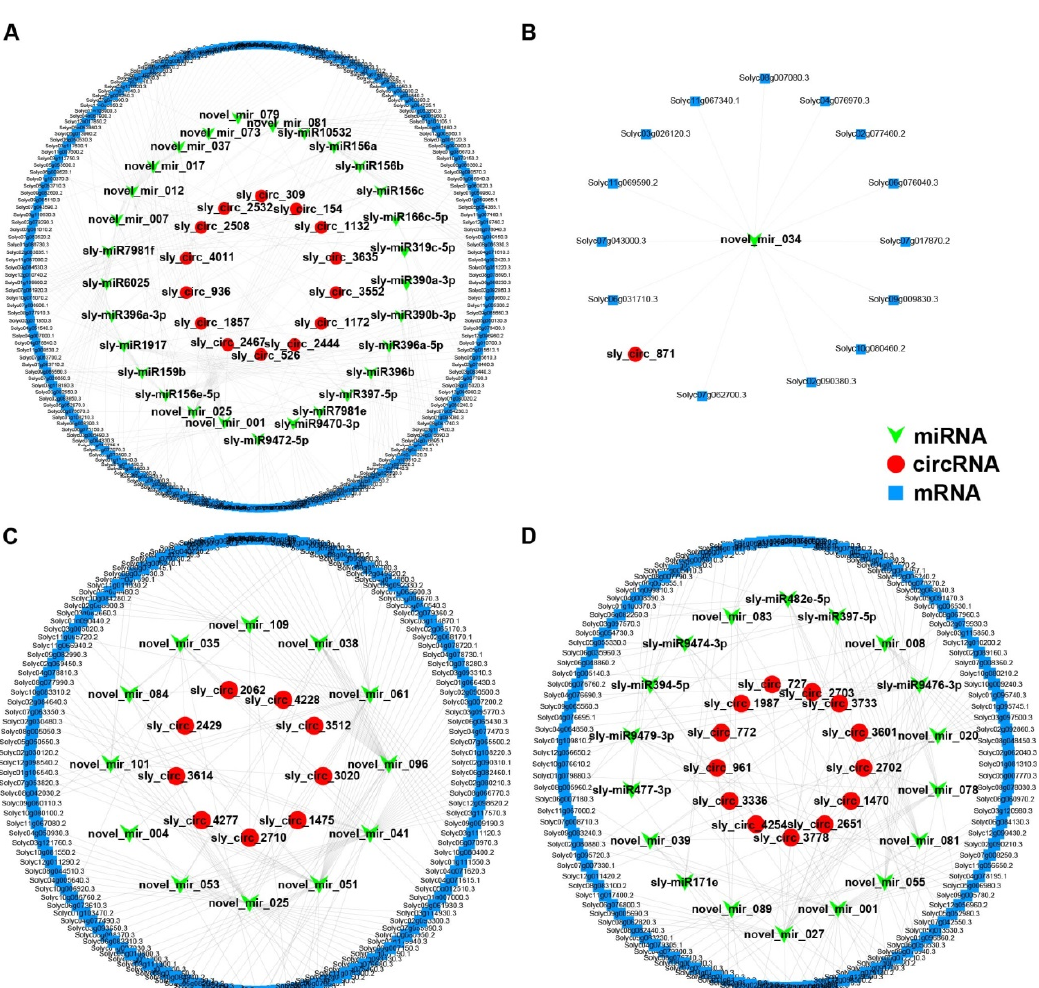
Figure 6. The circle plots of ceRNA (circRNA–miRNA–mRNA) networks. ( A , B ) The salt-responsive ceRNA network for M82, which was constructed with circRNA–miRNA and miRNA–mRNA pairs. The circRNAs, miRNAs, and mRNAs in ( A ) are up-regulated, down-regulated, and up-regulated, respectively. The expression patterns are the opposite in ( B ). ( C , D ) The salt-responsive ceRNA network for Solanum pennellii ( S. pennellii ). The circRNAs, miRNAs, and mRNAs in ( C ) are up-regulated, down-regulated, and up-regulated, respectively. The expression patterns are the opposite in ( D ).